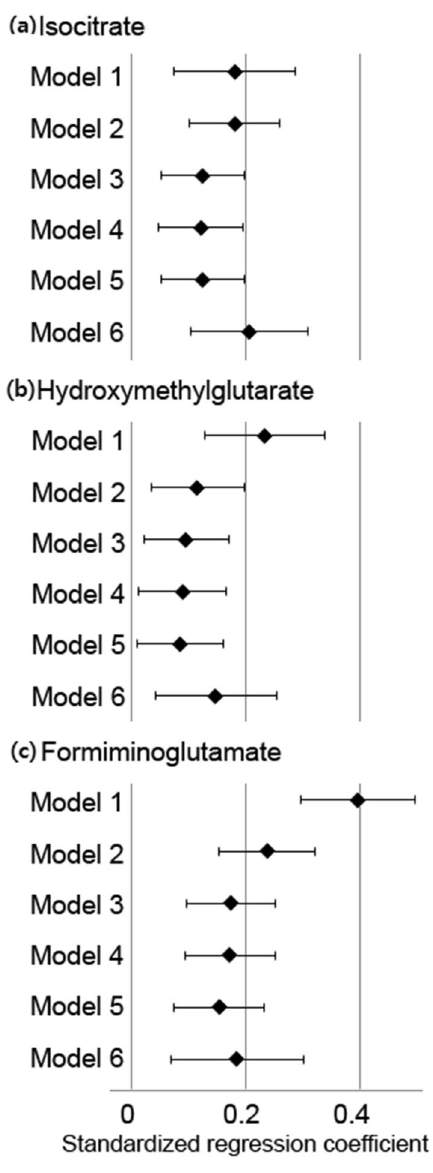
Figure 2. Standardized regression coefficients of the levels of key metabolites for baPWV. The concentrations of the key metabolites (isocitrate ( a ), hydroxymethylglutarate ( b ) and formiminoglutamate ( c )) are logarithmically transformed and inserted in the regression models. Model 1 constitutes crude models. Model 2 additionally includes the variables of age and sex. Model 3 additionally includes variables of mean BP and heart rate. Model 4 additionally includes variables of total cholesterol, HDL cholesterol, BMI. Model 5 additionally includes the following variables: medication history of hypertension, diabetes, and dyslipidemia, habits of smoking, significant alcohol consumption, and physical activity. In Model 6, the subjects with history of medications, smoking, and significant alcohol consumption were excluded. The covariates in Model 6 were same as those included in Model 4. Error bars show standard error of the means. BaPWV brachial-ankle pulse wave velocity, BP blood pressure, HDL high-density lipoprotein, BMI body mass